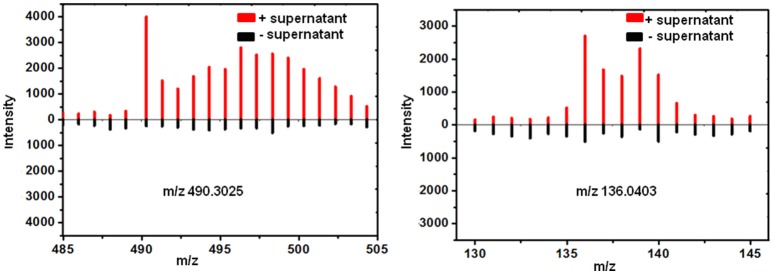
13C incorporation was not observed for the induced features on day 20 in the mono-culture of T. versicolor
(Left) or G. applanatum
(Right) without the addition of the supernatant of co-culture.